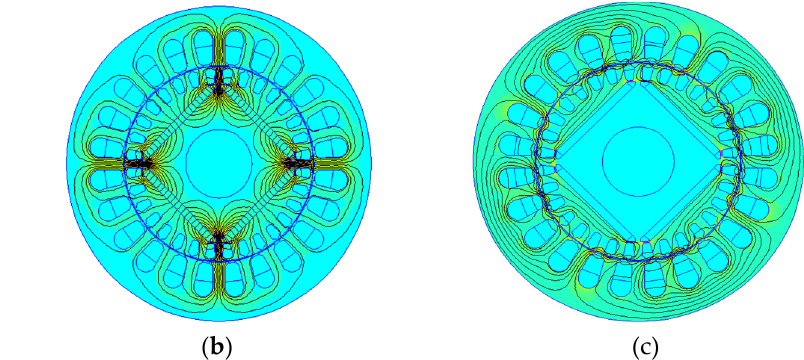
Figure 2. Line-start permanent magnet motor magnetic fields [7]: ( a ) stator winding fields; ( b ) permanent magnets fields; ( c ) stator and rotor magnetic fields.